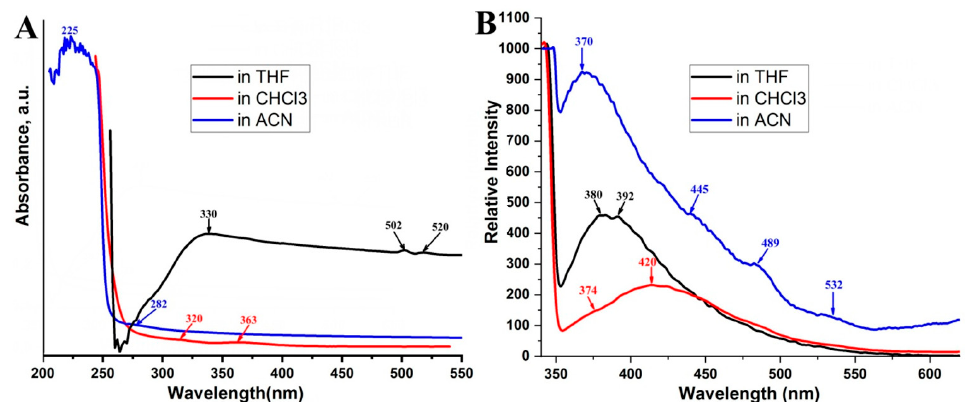
Figure 2. Absorption ( A ) and emission ( B ) spectra of Th-PDLLA in organic solvents of different nature (c = 1 mg/mL) ( λ ex = 330 nm).